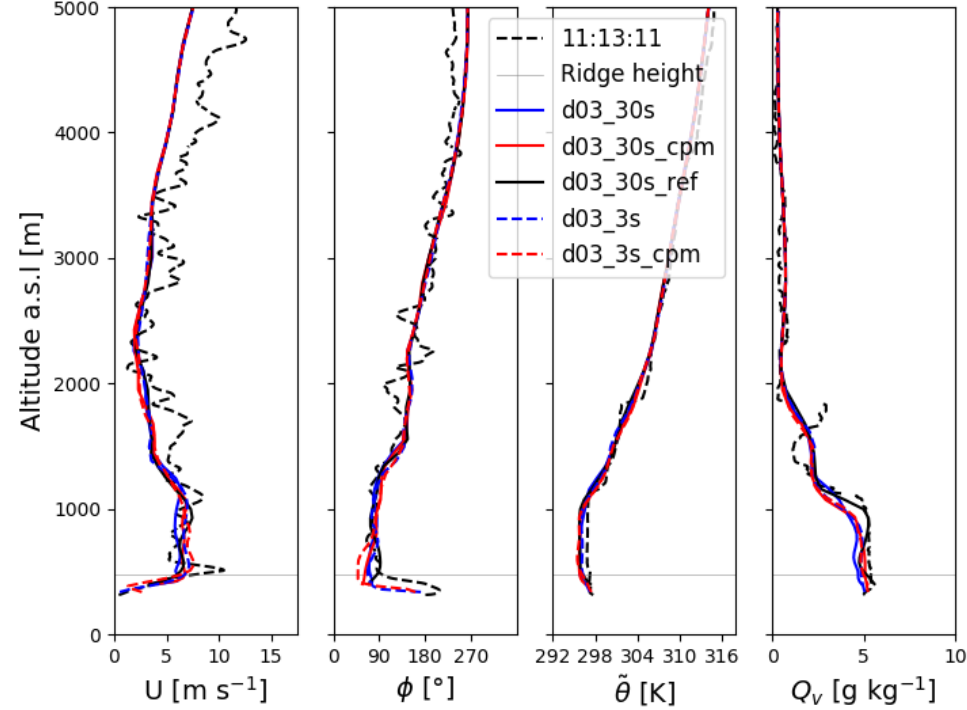
Figure 6. Profiles of wind speed, wind direction, potential temperature, and specific humidity comparing LES results to GAUSS radiosonde data from a sounding released from the center of the Vale do Cobrão (red ‘x’ in Figure 2) at 11:13:11 UTC 20 May 2017. The horizontal gray line, labeled ‘Ridge height,’ is given as 473 m a.s.l., corresponding to the base of